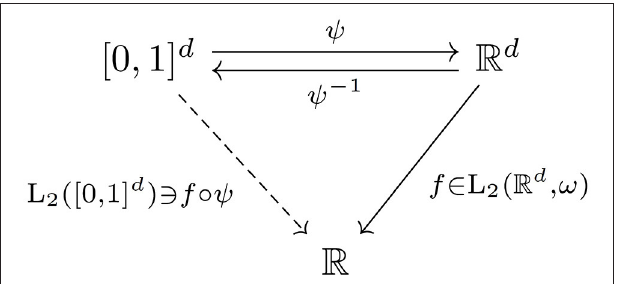
FIGURE 2 | Commutative diagram of the function and the transformations.